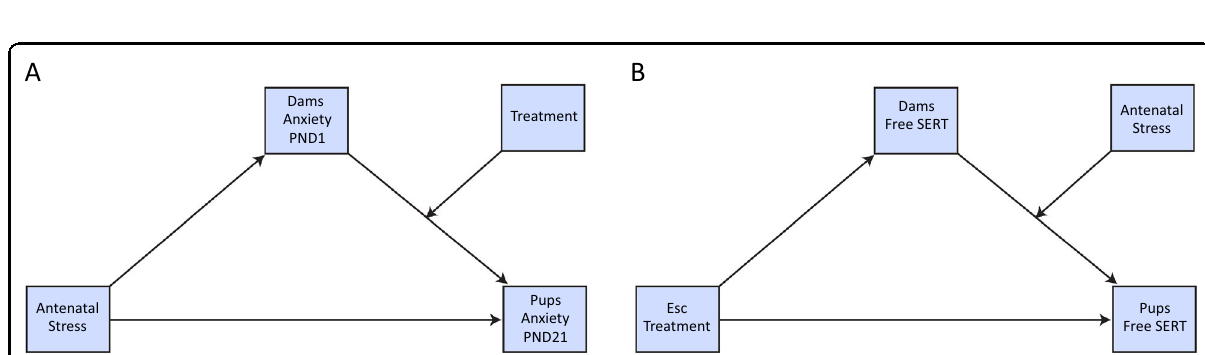
Fig. 2 Conceptual depiction of the moderated mediation models. A A diagram of the hypothesized moderated mediation model on the effect of antenatal stress on pups ’ anxiety-like behavior, with dams ’ anxiety-like behavior on PND 1 as the mediator, and escitalopram and shan-zha treatments as moderators. B A diagram of the hypothesized moderated mediation model on the effect of escitalopram treatment to lactating dams on pups ’ escitalopram exposure (expressed as pups ’ free SERT), with dams ’ escitalopram levels as the mediator, and antenatal stress as the